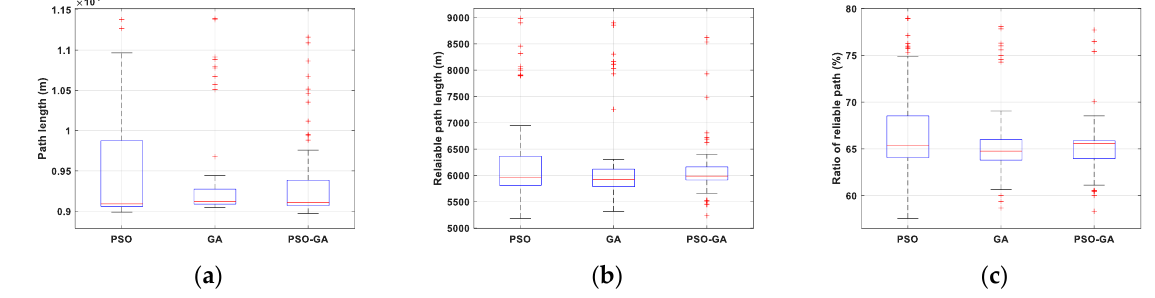
Figure 11. Statistical results of Scenario II: ( a ) optimal path, ( b ) reliable path, and ( c ) ratio of the reliable path.